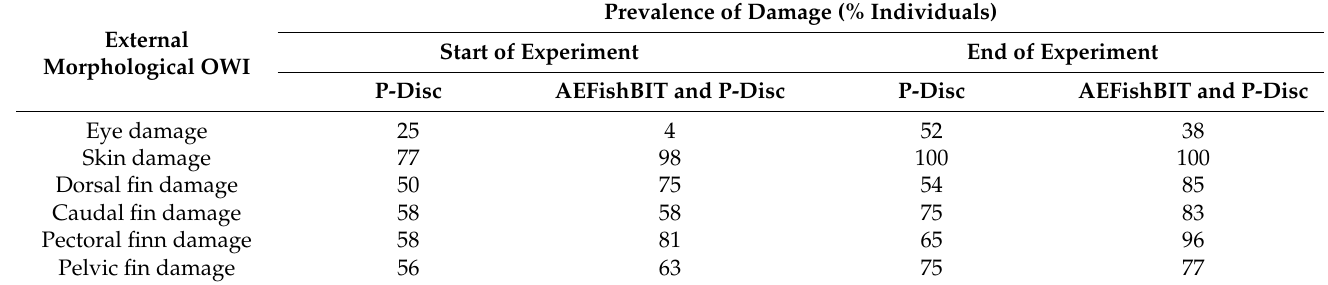
Table 2. Prevalence of damage of evaluated external morphological operational welfare indicators (OWI) recorded at the start of the light intensity experiment (before tagging) and at the end of experiment. In total, 48 individuals in both tagged groups (P-disc and AE-FishBIT with P-disc) were evaluated prior to tagging and at the end of experiment.